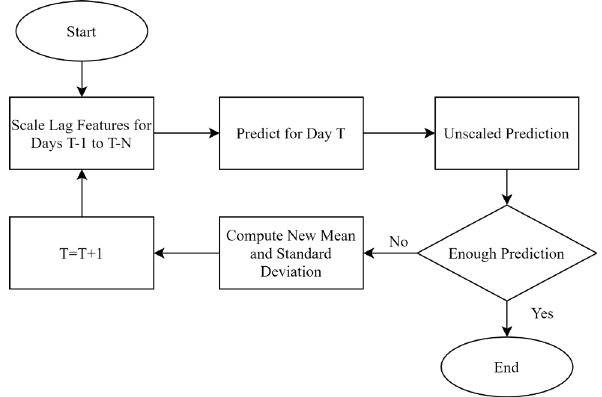
Figure 4. XGBoost Model for Prediction